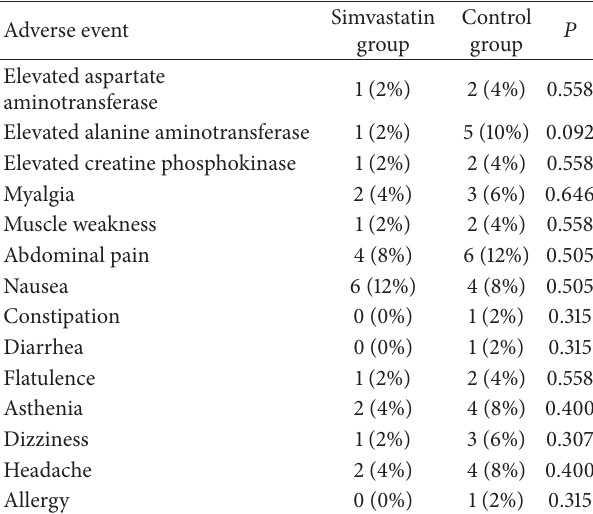
Table 3: Adverse